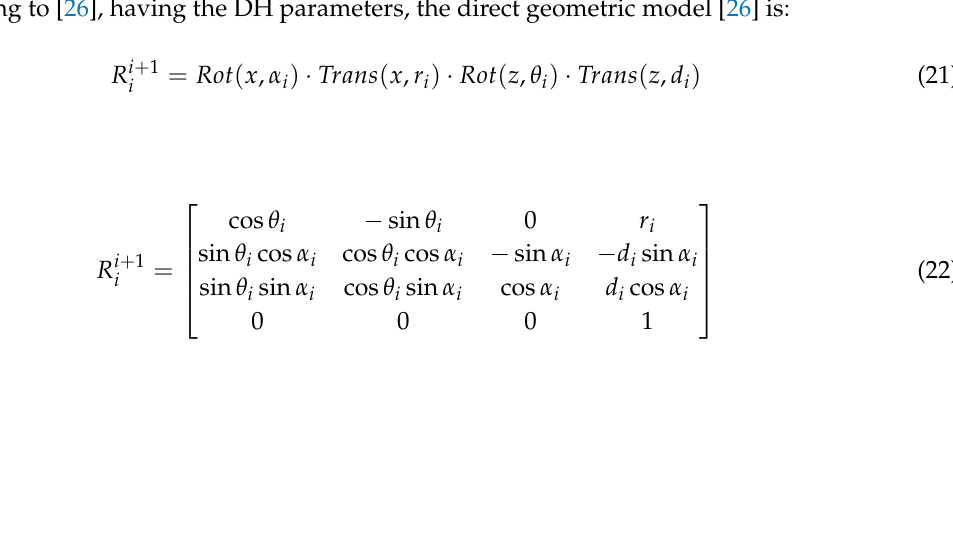
Figure 7. N segment inverted pendulum on a cart with mass-spring-damper